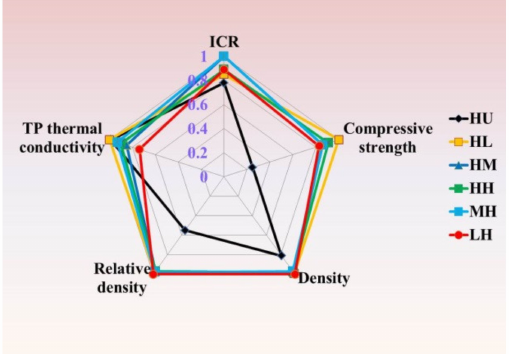
Figure 10. Thermal-electrical-mechanical property of composite